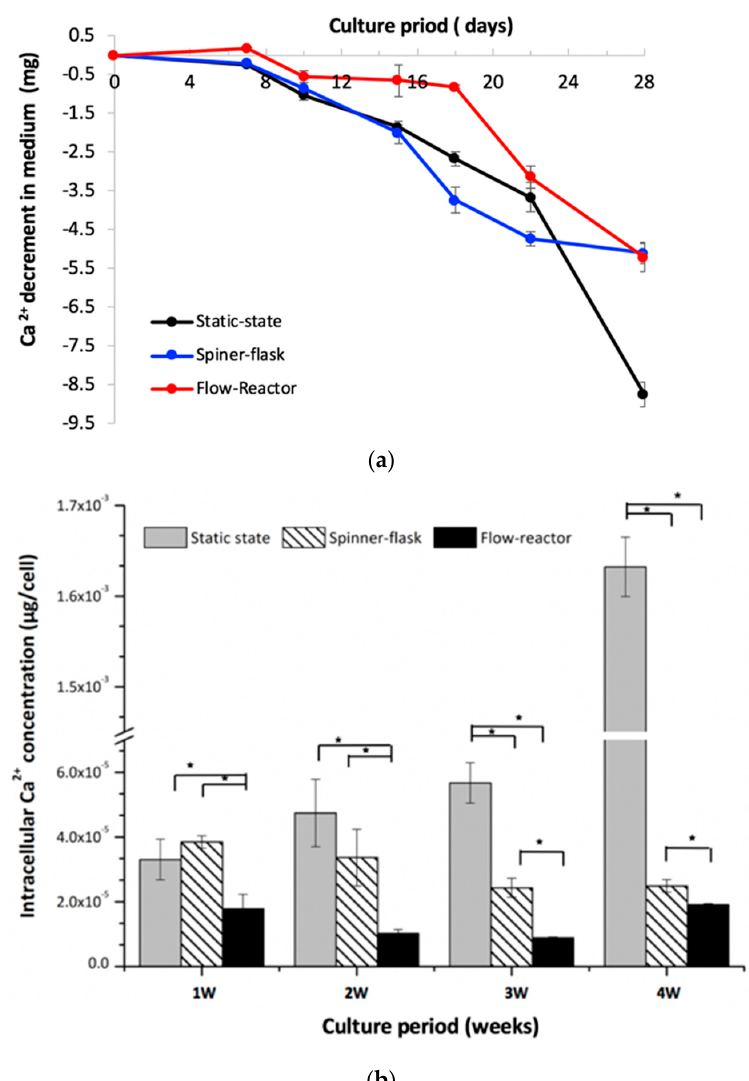
Figure 4. ( a ) For the Ca 2 + concentration in culture media, there was no obvious change among the three groups in the first seven days; ( b ) for the intracellular calcium quantification, there was no significant di ff erence between the static-state culture and spinner-flask bioreactor at week one and two. However, the static-state culture had significantly higher Ca 2 + contents relative to the spinner flask at week three and four. The spinner flask also had significantly higher Ca 2 + contents when compared to those of the flow reactor during the four-week experimental